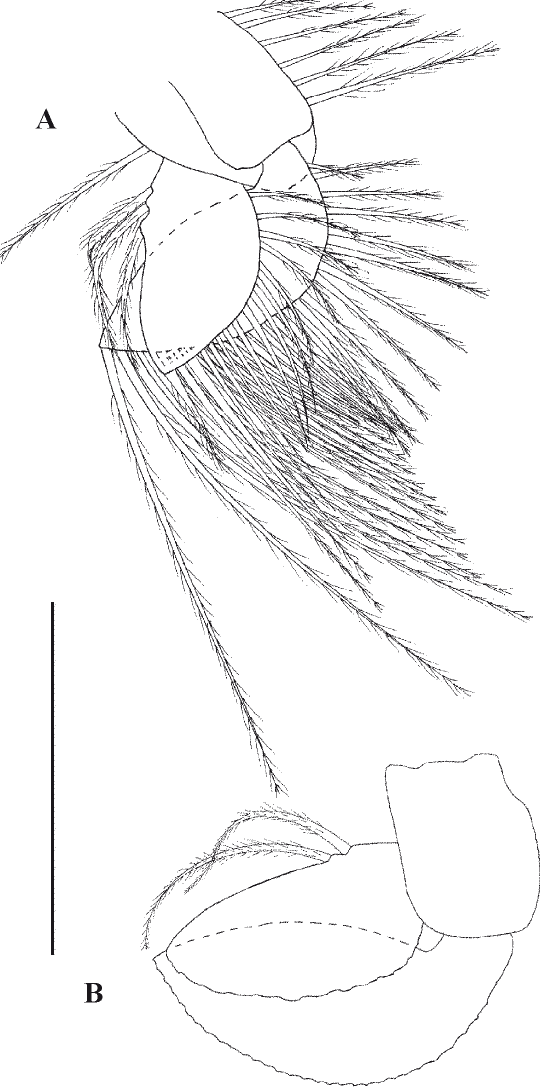
Fig. 3. – Pleopod endopod setation. A, Zeuxo holdichi, pleopod 1. B, same, pleopod 3, outer rami setae omitted. Scale bar, 0.5